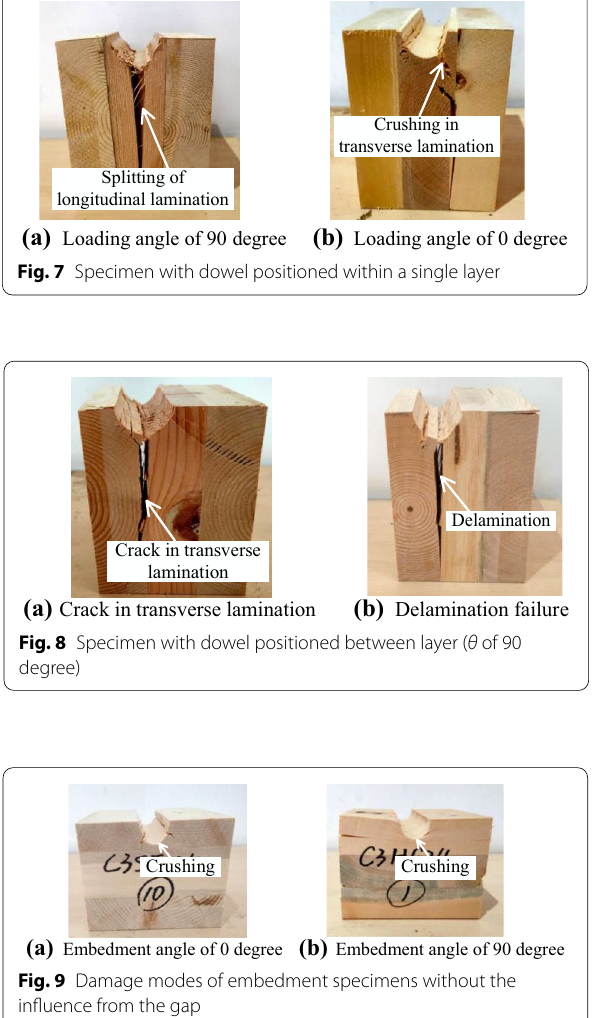
Fig. 9 Damage modes of embedment specimens without the influence from the gap